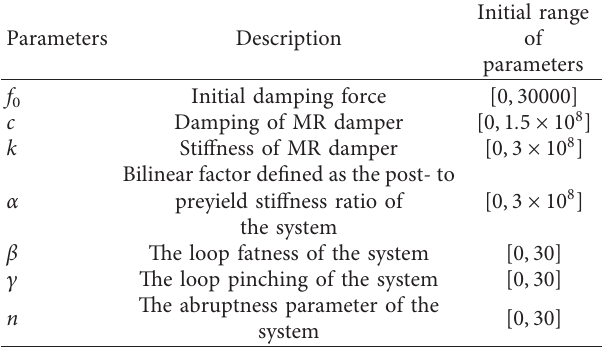
Table 7: The parameters encoded in the IMPSCO for the MR damper